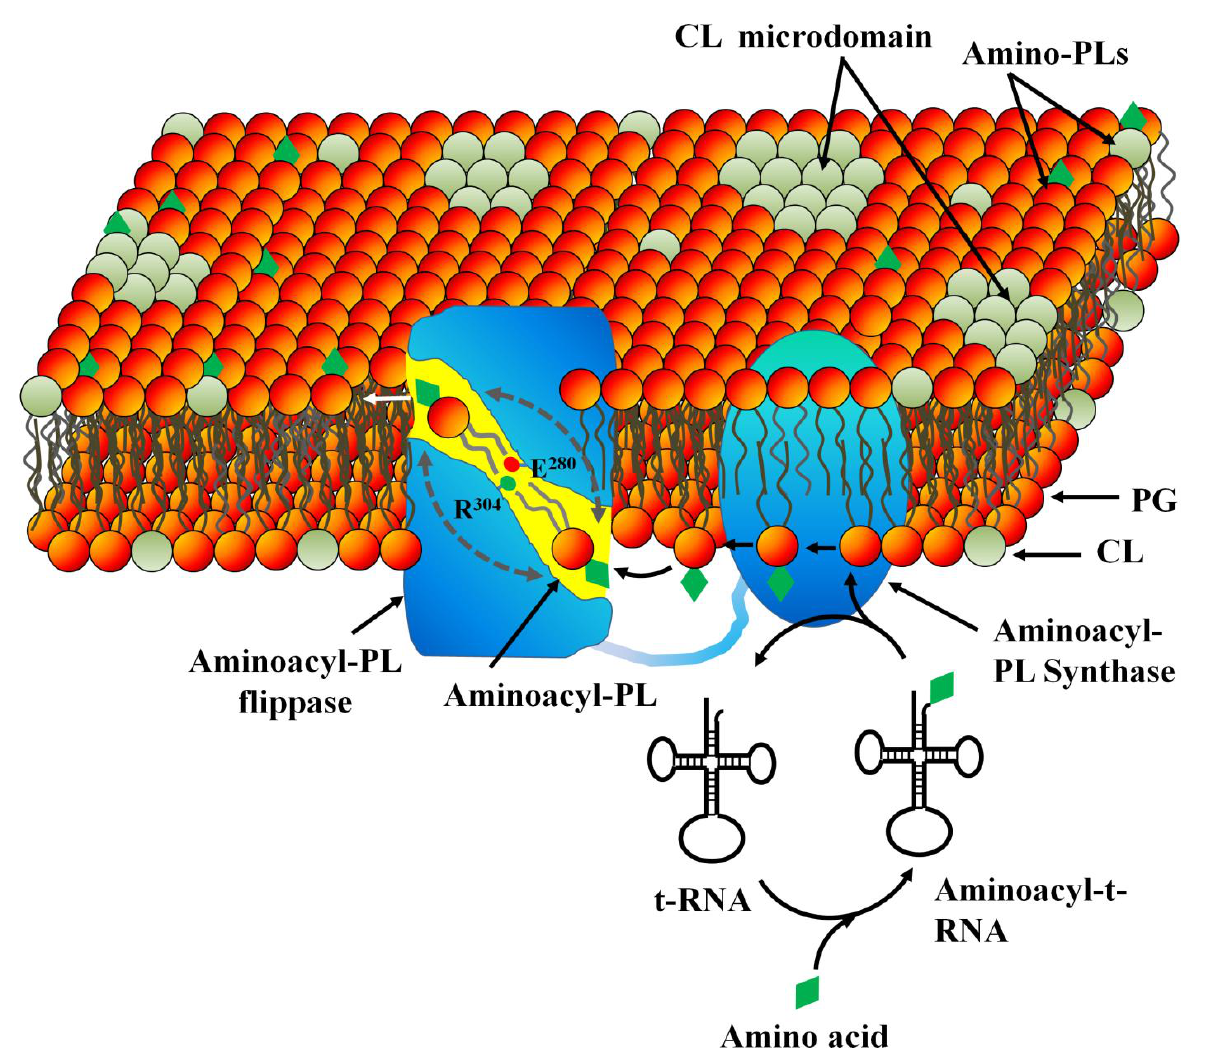
Figure 3. Modification of bacterial inner-membrane lipids leading to multi-drug resistance. The negatively charged PLs in IM of MDR Gram-negative bacteria (e.g., P . aeruginosa ) and the only membrane of Gram-positive bacteria (e.g., S . aureus ) are modified by addition of aminoacyl groups such as alanine and Lysine. The multiple peptide resistance factor (MPRF), a protein localized to the PM, possesses two distinct domains: aminoacyl-PL synthase and aminoacyl-PL-flippase, which work in concert. The aminoacyl-PL synthase domain catalyzes the transfer of an activated aminoacid (green rhombus) such as Ala or Lys to a PG or CL bound to the active site of MPRF near to the inner leaflet of IM. The aminoacyl-PL diffuses to the active site of the flippase domain; from there it is flipped to the outer leaflet through a lipophilic pathway that is gated by two charge amino acids: E280 and R304. The gating mechanism greatly decreases the free energy of translocation plausibly by replacing the water of hydration. The lipid molecule is inverted 180 ◦ (indicated by double-headed arrow) within the MPRF to diffuse into the outer leaflet, populating it with aminoacyl-PLs. Increased aminoacyl-PL content in the outer leaflet alters the membrane physical properties such as charge and fluidity, decreasing its affinity for the CAMPs such as daptomycin or other membranolytic